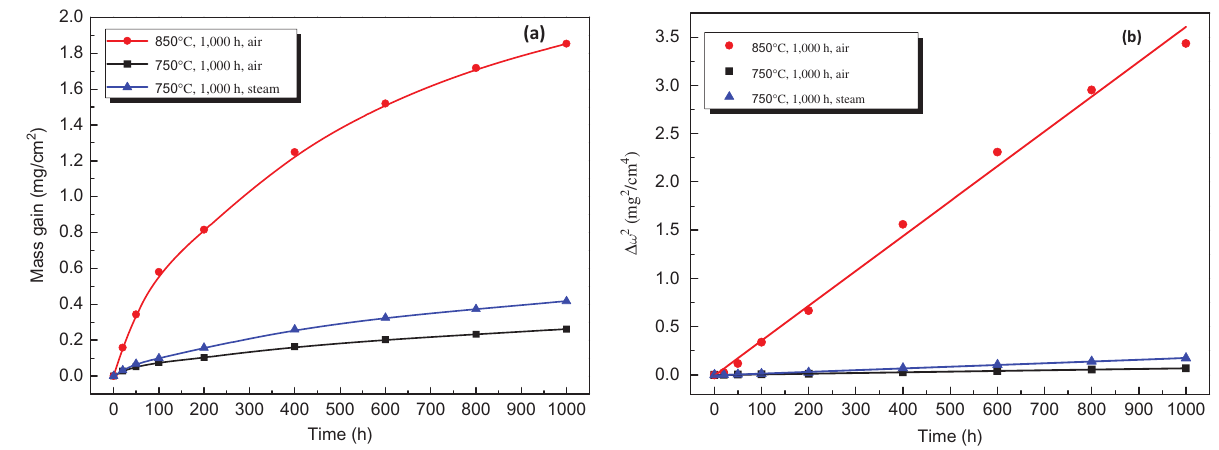
Figure 1: Oxidation behavior of Inconel 740H: (a) oxidation kinetics and (b) oxidation rate.